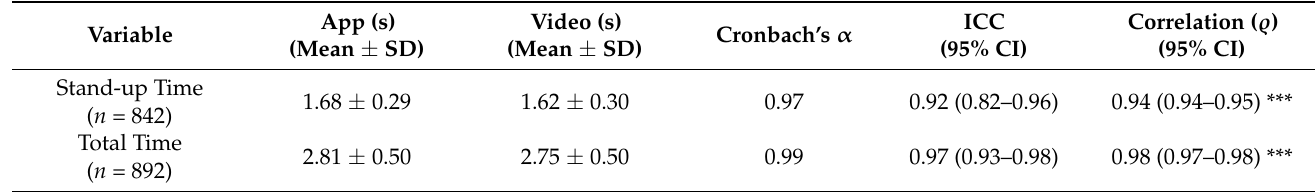
Table 2. Relative reliability and relationship